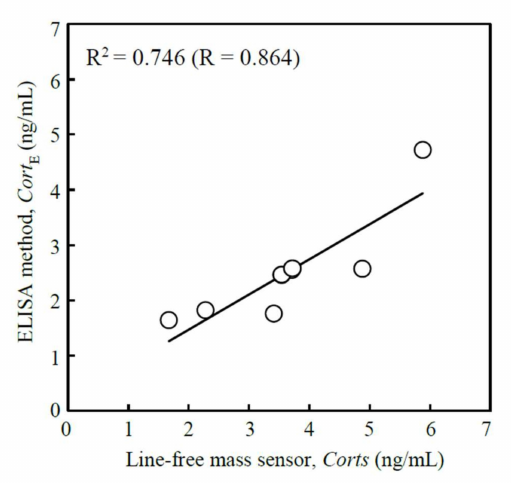
Figure 12. Scatter plot visualizing correlation of cortisol concentrations between a conventional assay (enzyme-linked immunosorbent assay (ELISA) method) and the fabricated line-free mass sensor in the use of human saliva